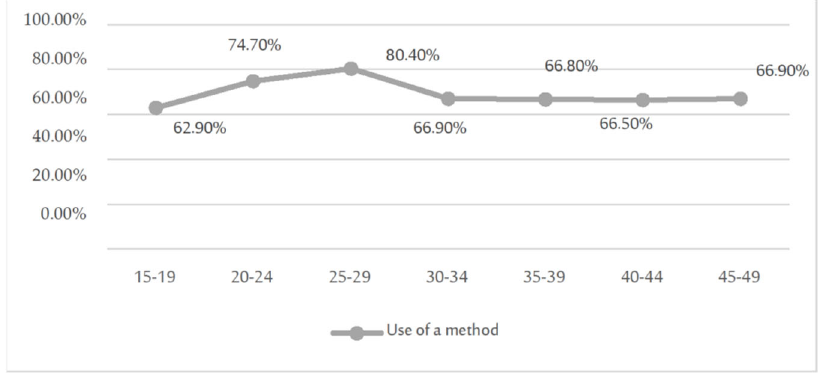
Figure 5. Use of some contraceptive method according to age group.